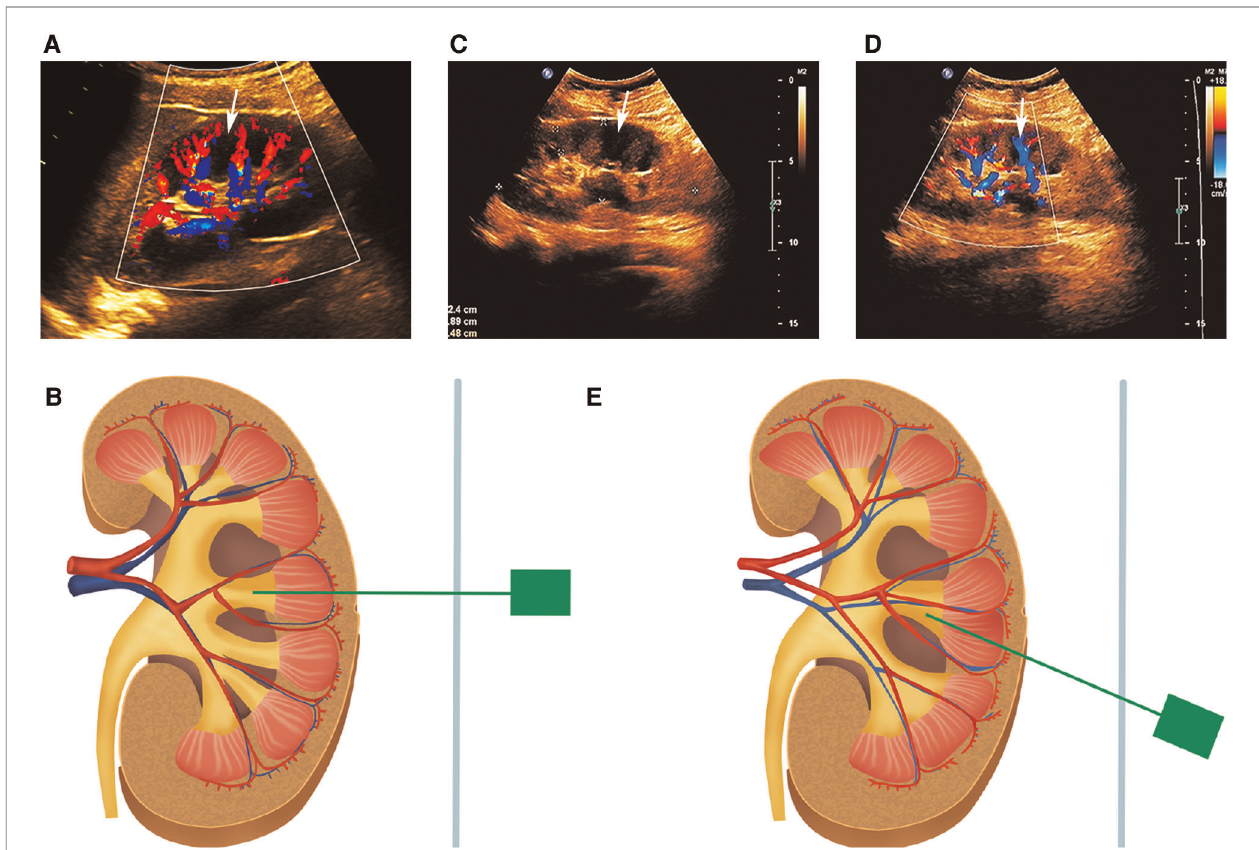
FIGURE 3 | ( A ) NRP and the simple calyx in Doppler ultrasound. There are blood fl ow signals in the renal columns on either side of the NRP. The white arrow indicates the NRP. ( B ) Schematic representation of the axial puncture of the calyx corresponding to NRP. ( C,D ) FRP and the compound calyx in B-mode ultrasound and Doppler ultrasound. The white arrow indicates the FRP. Color fl ow signals exist within FRP. ( E ) Schematic representation of calyx puncture through the hypovascular area of the FRP. NRP, normal renal pyramid; FRP, fused renal